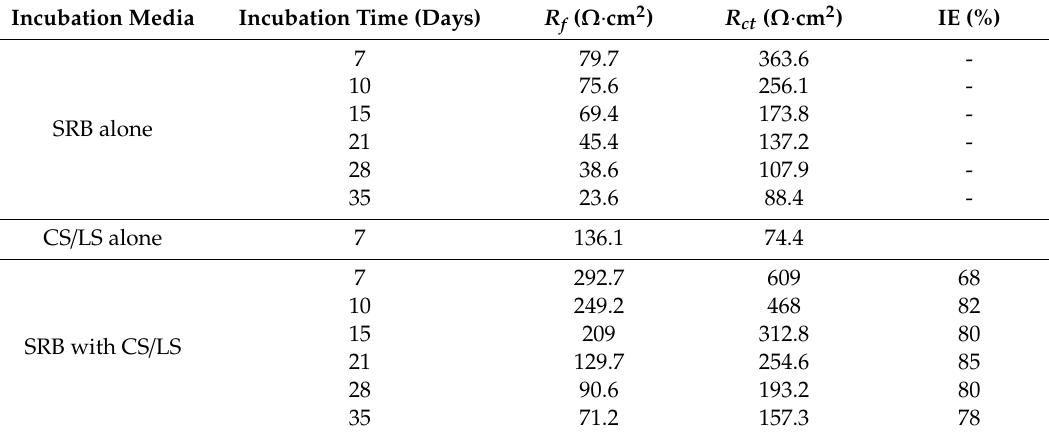
Table 1. R ct , R f and IE values after EIS